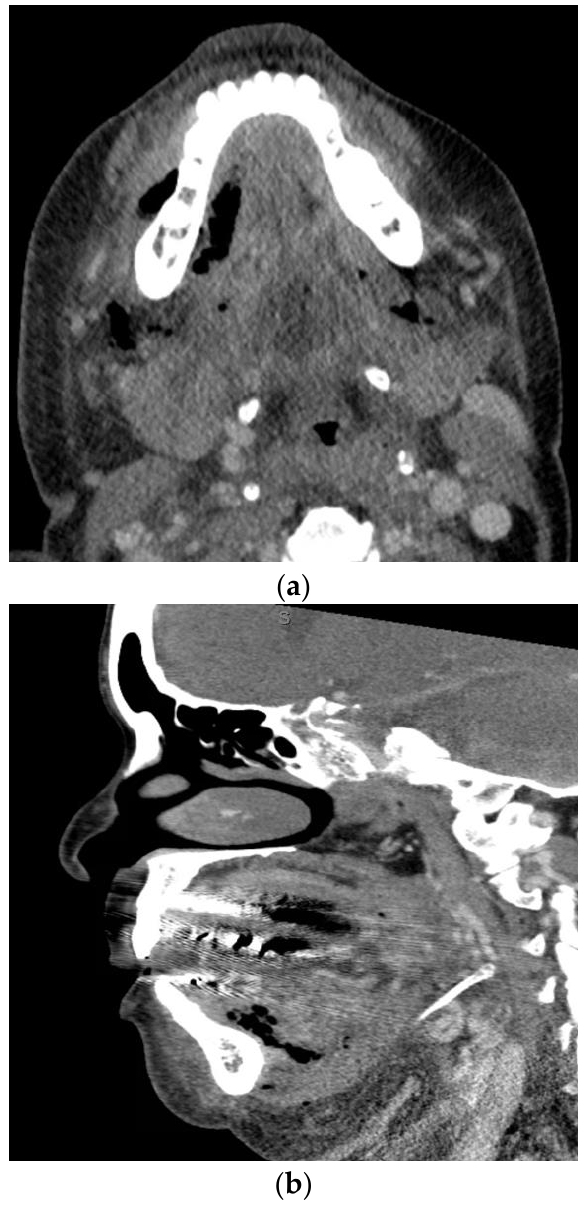
Figure 2. Axial ( a ) and sagittal ( b ) computed tomography scan views of a patient with Ludwig’s angina. The symptoms of severe odontogenic infections include trismus, pain, swelling, dys- phagia, dysphonia, and fever [29]. Many of these symptoms make securing the airway more challenging. Additionally, distortion of the anatomy and immobility of the tissues may create a difficult scenario for the provider attempting to establish a secure airway. In a study by Riekert et al. of 499 severe odontogenic infection patients, limited mouth opening was associated with difficult airway management. In the same study, four patients (0.8%) required tracheostomy [30]. Intubation methods such as flexible bronchoscopy and video- assisted laryngoscopy have improved the ability to establish an airway in patients with severe odontogenic infections. In a study by Schumann et al. of 100 patients with se- vere odontogenic infections, video-assisted laryngoscopy was successful in all patients while conventional tracheal intubation failed in 17 out of 50 patients [31]. Both flexible bronchoscopy and video-assisted laryngoscopy have high success rates and have certainly contributed to the decreased mortality seen in patients treated for Ludwig’s angina